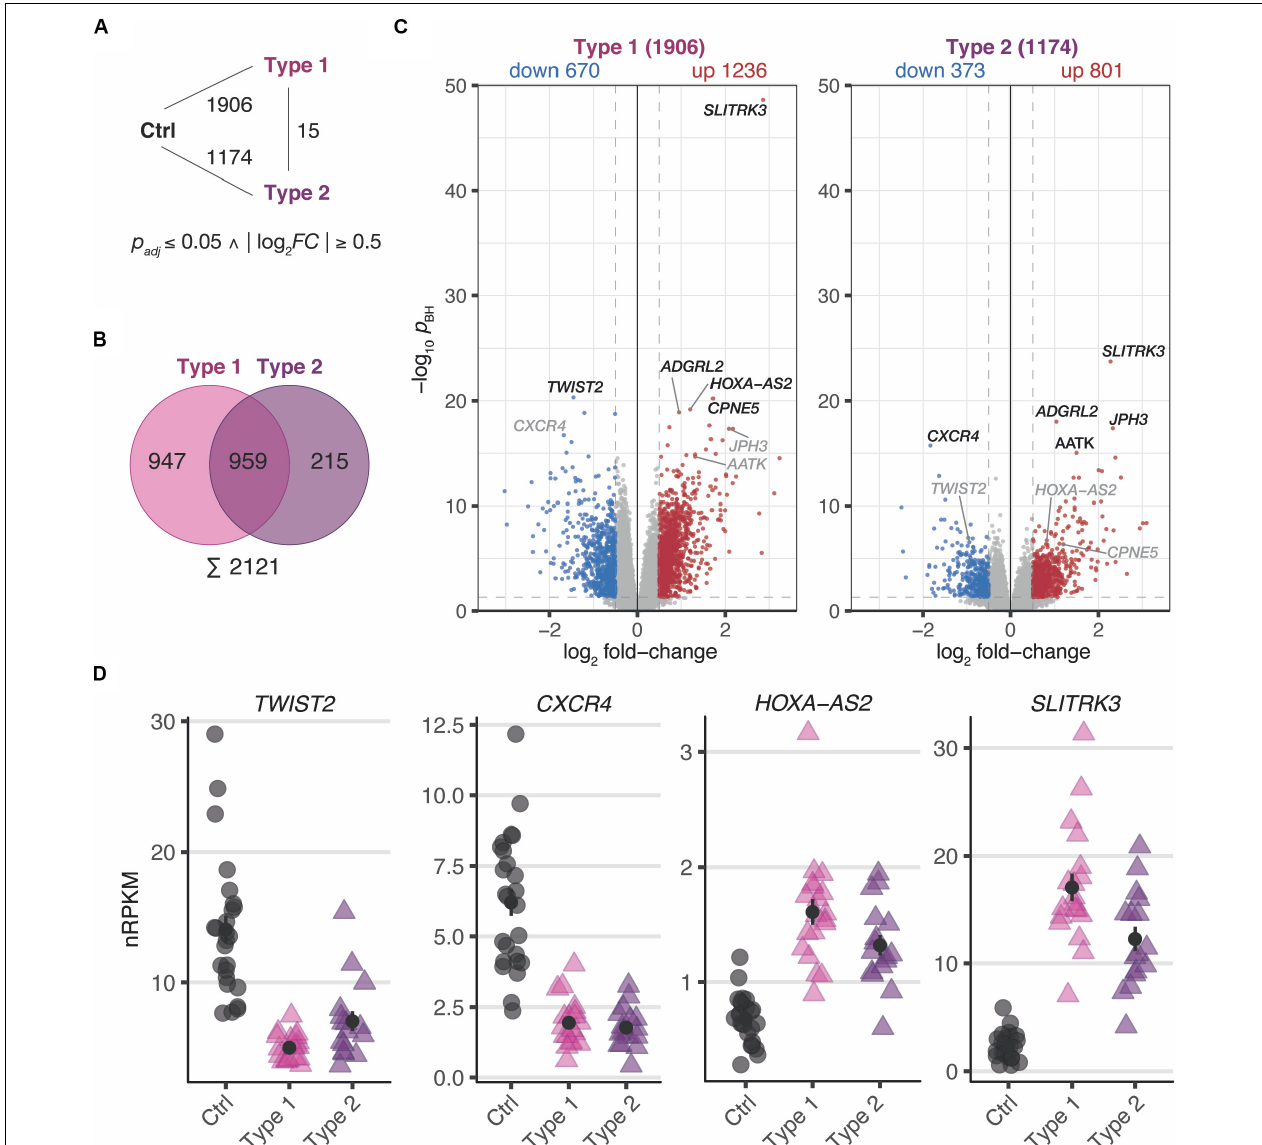
FIGURE 1 | MRKH patients exhibit wide-spread gene expression changes in endometrial tissue compared to unaffected controls. (A) Schematic diagram of three experimental groups (Ctrl, unaffected women; Type 1, patients with MRKH type 1; and Type 2, patients with MRKH type 2) indicating number of differentially expressed genes (DEGs) for each pairwise comparison. Fold change and significance cut-offs below. (B) Venn diagram comparing common and distinct DEGs between MRKH types 1 and 2. (C) Volcano plot showing magnitude and significance values of gene expression changes identified in endometrial tissue of MRKH type 1 (left panel) and MRKH type 2 patients (right panel) compared to unaffected controls. Blue and red dots highlight DEGs according to the applied cut-offs (see panel A ). The five most significant DEGs from each comparison are labeled. Gray gene labels indicate location of DEGs from the other comparison. (D) Expression levels for the most significant up- and downregulated DEGs as well as the lincRNA HOXA-A2 plotted as individual data points with mean ± SEM.